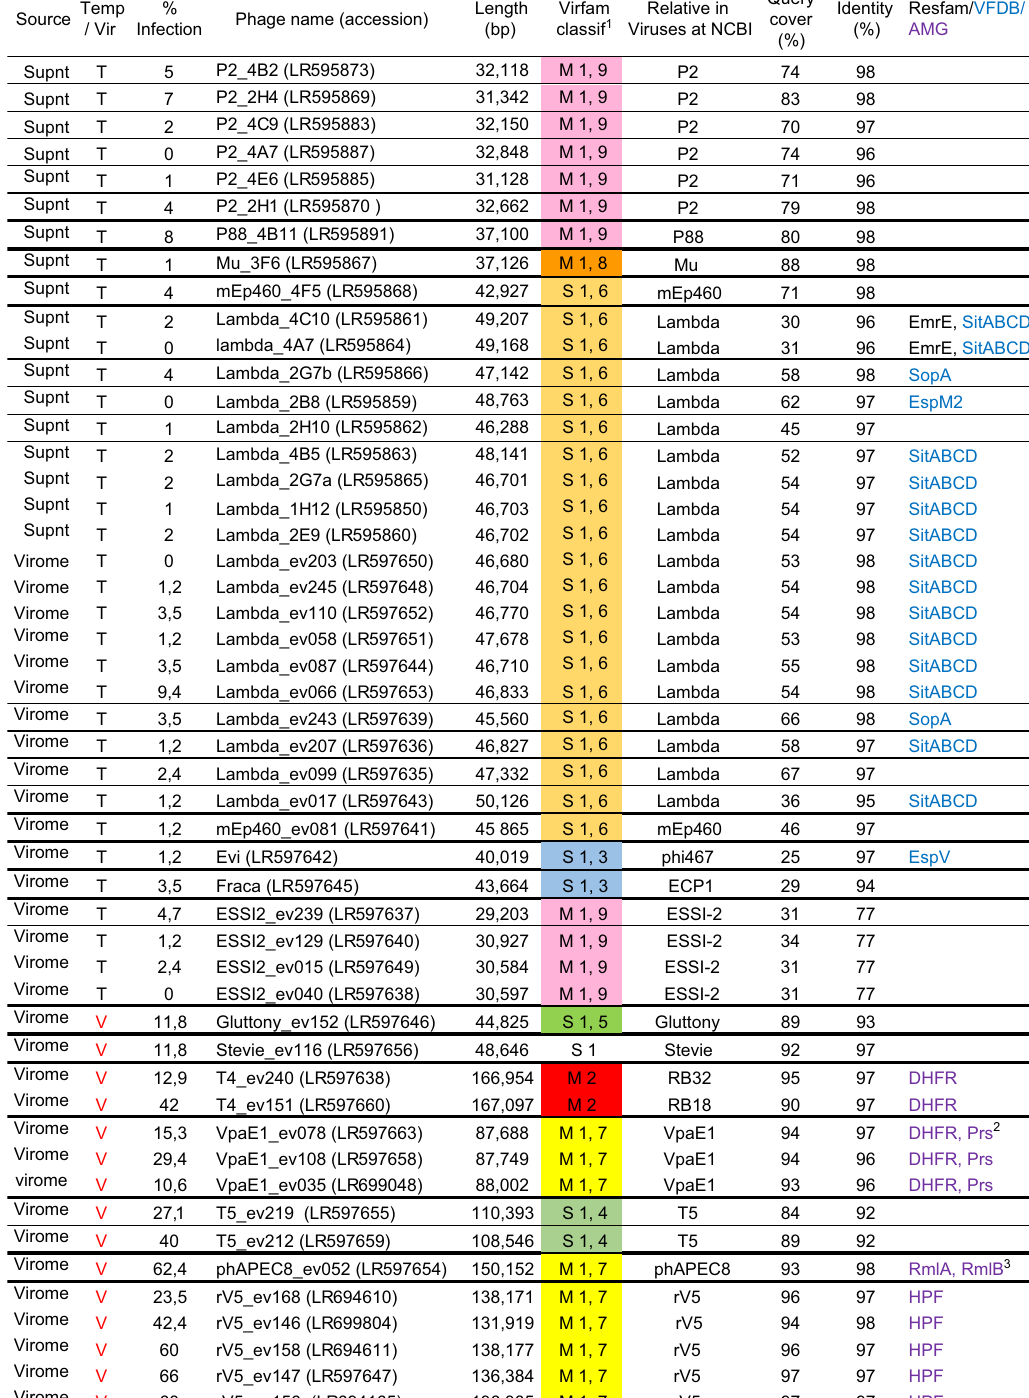
Fig. 4 Characteristics of the 50 sequenced coliphages genomes. (1) M = myophage, S = siphophage. The fi rst number denotes the Virfam Type. Second number is cluster number in Type 1. Each Virfam assignment is color coded as in the Virfam tree. The absence of any line between two phages indicates they belong to the same species (>95% id and >85% coverage with megablast). (2) Prs, Ribose-phosphate pyrophosphokinase. (3) RmlA, glucose-1- phosphate thymidylyltransferase; RmlB, dTDP-D-glucose